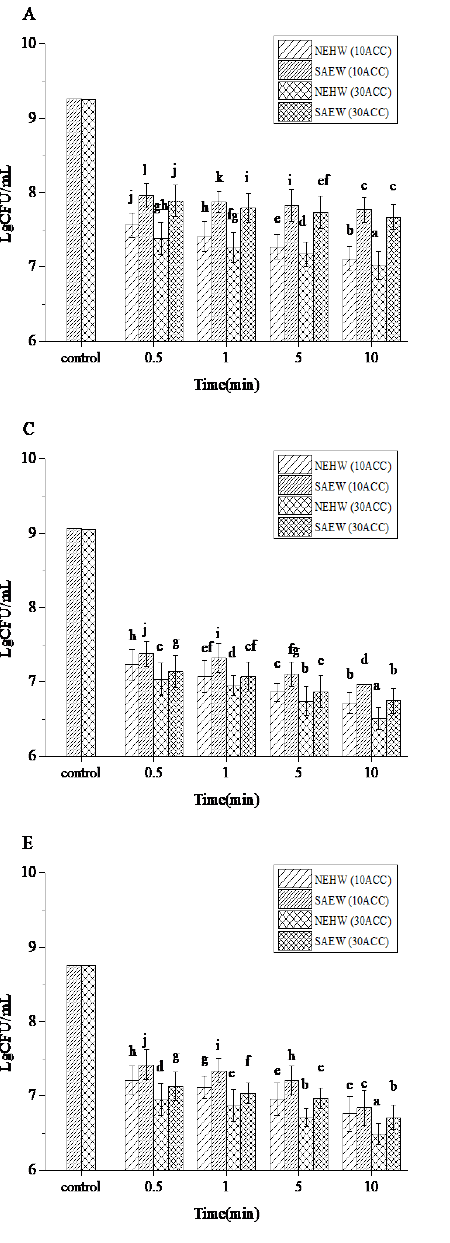
Figure 1. The number of remaining colonies of five bacteria after treatment with different concentrations of biocide and sterilization time, expressed by logarithm. ( A ) Listeria monocytogenes ; ( B ) Escherichia coli ; ( C ) Staphylococcus aureus ; ( D ) Candida albicans ; ( E ) Bacillus subtilis . All treatments and determinations were performed in triplicate. The different letters indicate significant differences ( p < 0.05). Values are the means of three replicated measurements ± standard deviation (SD). The populations of L. monocytogenes , E. coli , S. aureus , C. albicans , and B. subtilis control groups treated with tap water were 9.25, 8.93, 9.05, 9.00, and 8.75 cfu/mL. At 0.5 and 1 min of treatment, the biocides with two effective chlorine concentrations significantly reduced the number of five bacteria, but did not reach the 99% bactericidal rate. After 5 min of treatment, under 10 ACC, NEHW made L. monocytogenes , E. coli , S.